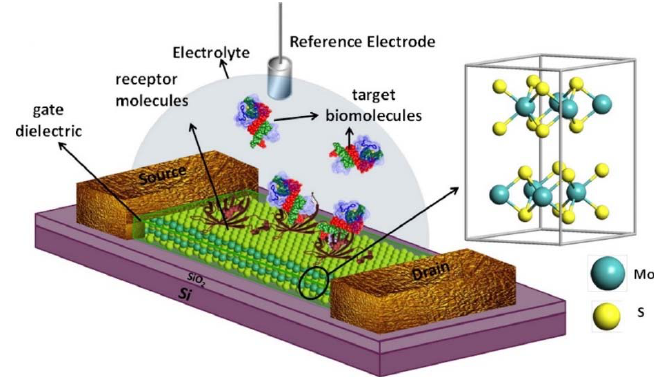
Figure 7. Schematic diagram of MoS 2 -based FET biosensor. For biosensing, the dielectric layer, covering the MoS 2 channel, is functionalized with receptors for specifically capturing the target biomolecules. The charged biomolecules, after being captured, induce a gating effect, modulating the device current. An electrolyte gate is in the form of a reference electrode (Ag/AgCl) is used for applying bias to the electrolyte. Adapted with permission from [53]. Copyright 2014 American Chemical Society.